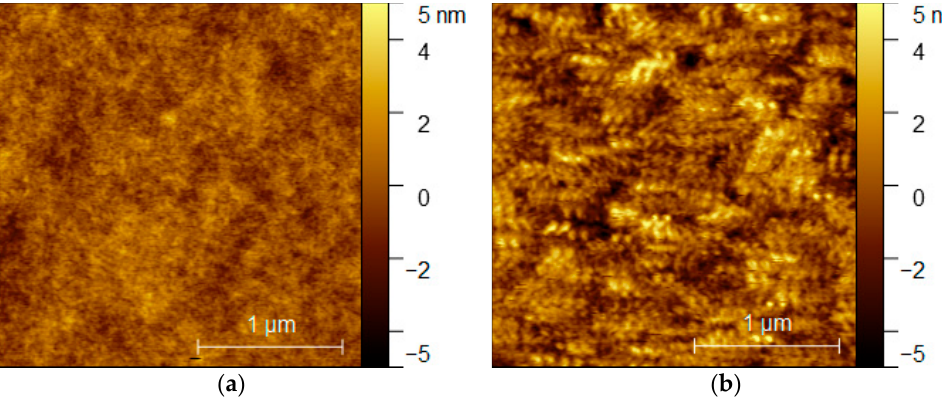
Figure 5. AFM characterization of ( a ) PTB7-Th:IDTz-BARO and ( b ) PTB7-Th:IDTz-BARS.